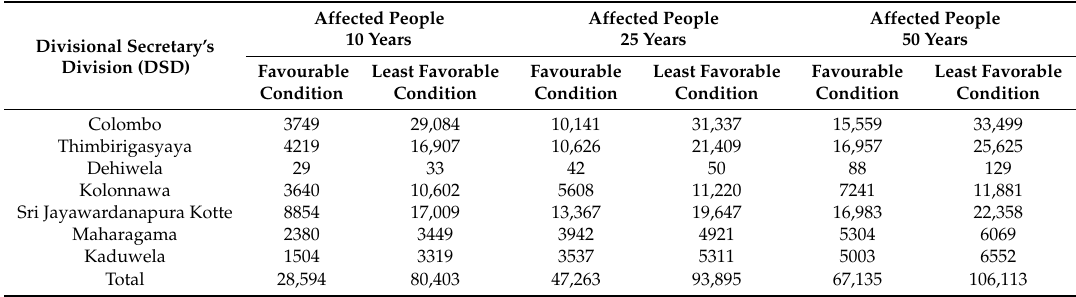
Table 5. Comparison of affected people for design rainfalls under favourable and worse